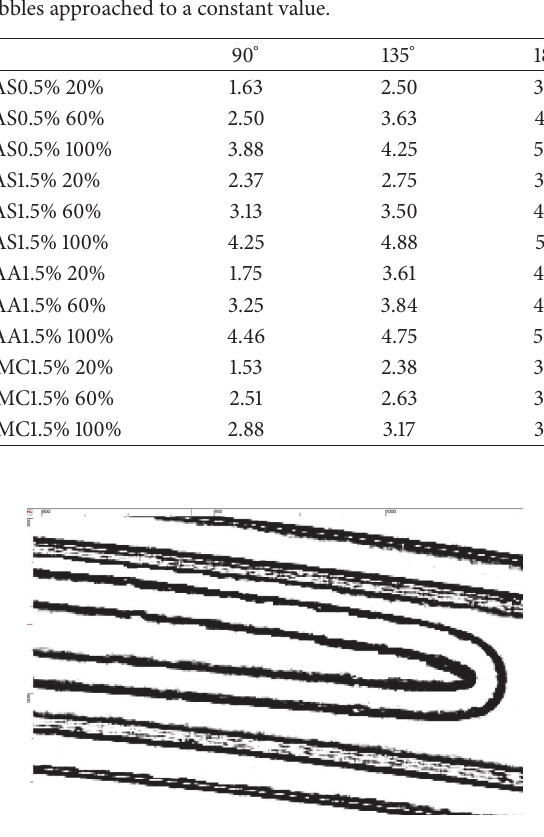
Figure 18: Zoom in